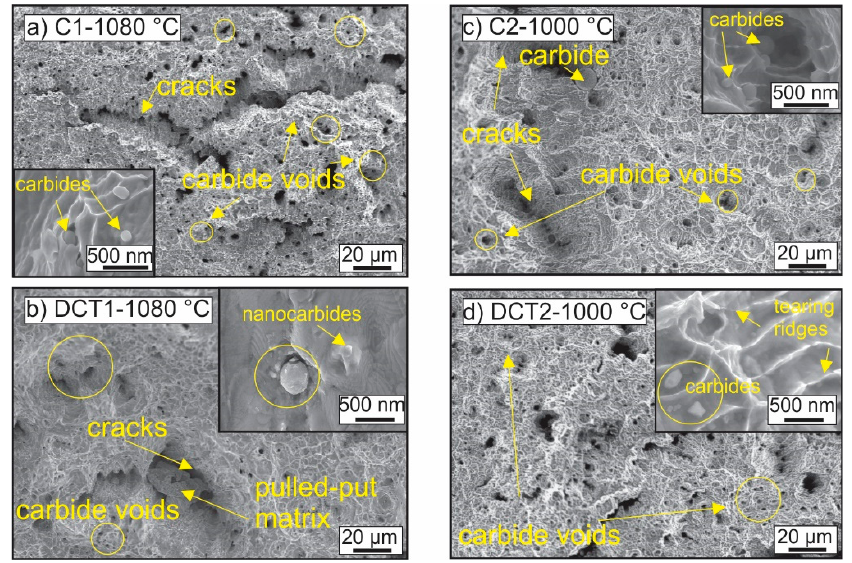
Figure 9. Fractograms of cracked samples of all four heat treatment groups (C1/C2 are conventional solution annealed ( a and c ), and DCT1/DCT2 are deep cryogenically treated ( b and d )). The images present individual regions with denser smaller-sized dimples (encircled regions) that are formed due to the presence of nanoscopic carbides, which are further presented through individual enlargements for each sample subgroup.